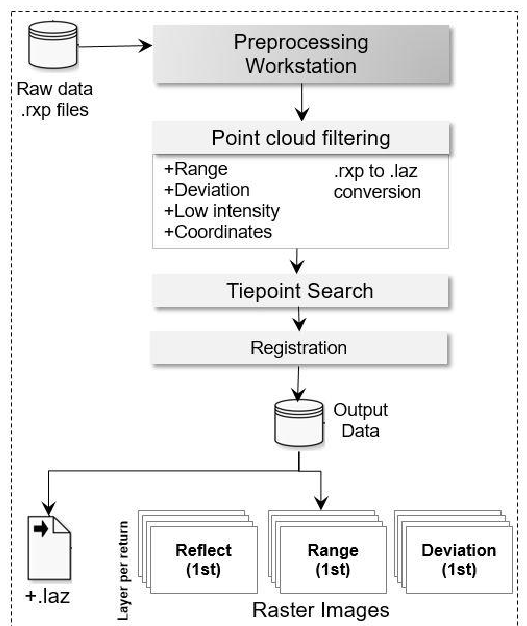
Figure 3. Preprocessing workflow and output data.